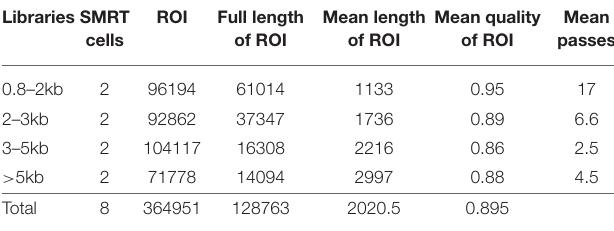
TABLE 1 | PACBio sequencing